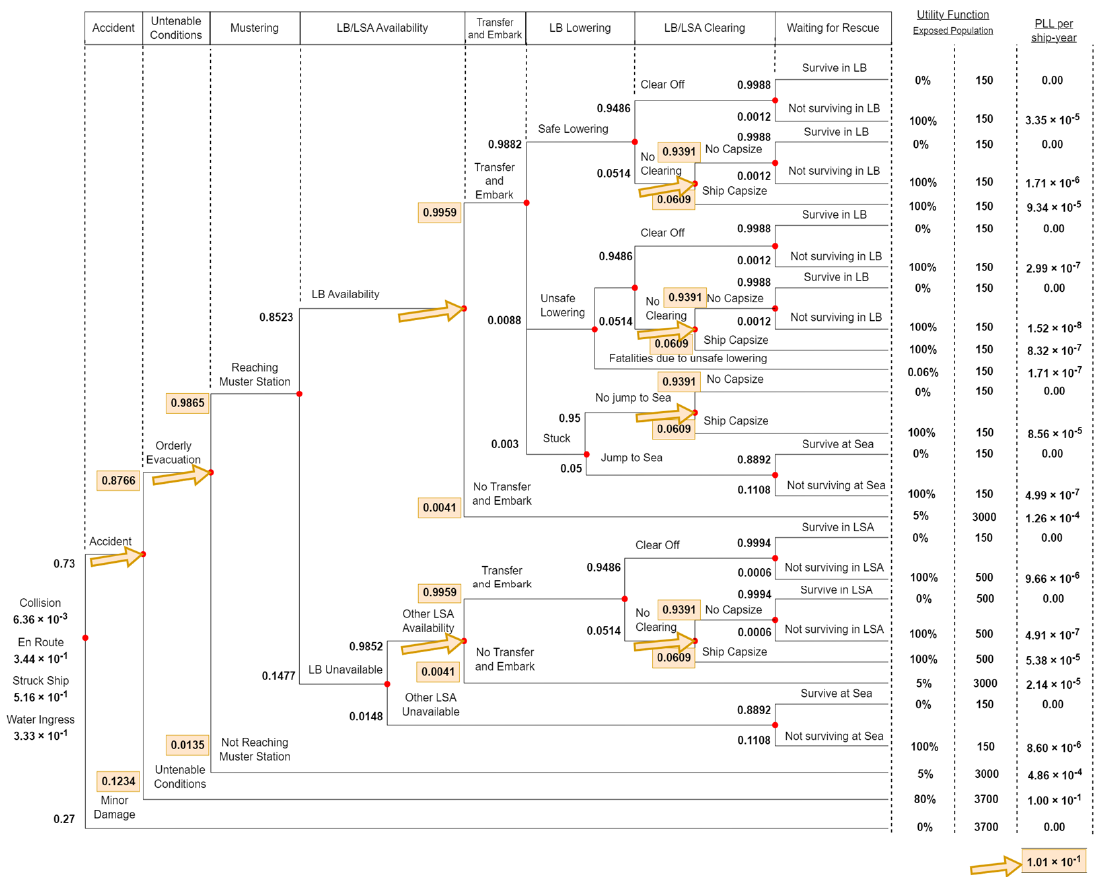
Figure 12. Event tree calculations and results for collision accidents, by considering the Dynamic Exit Signs’